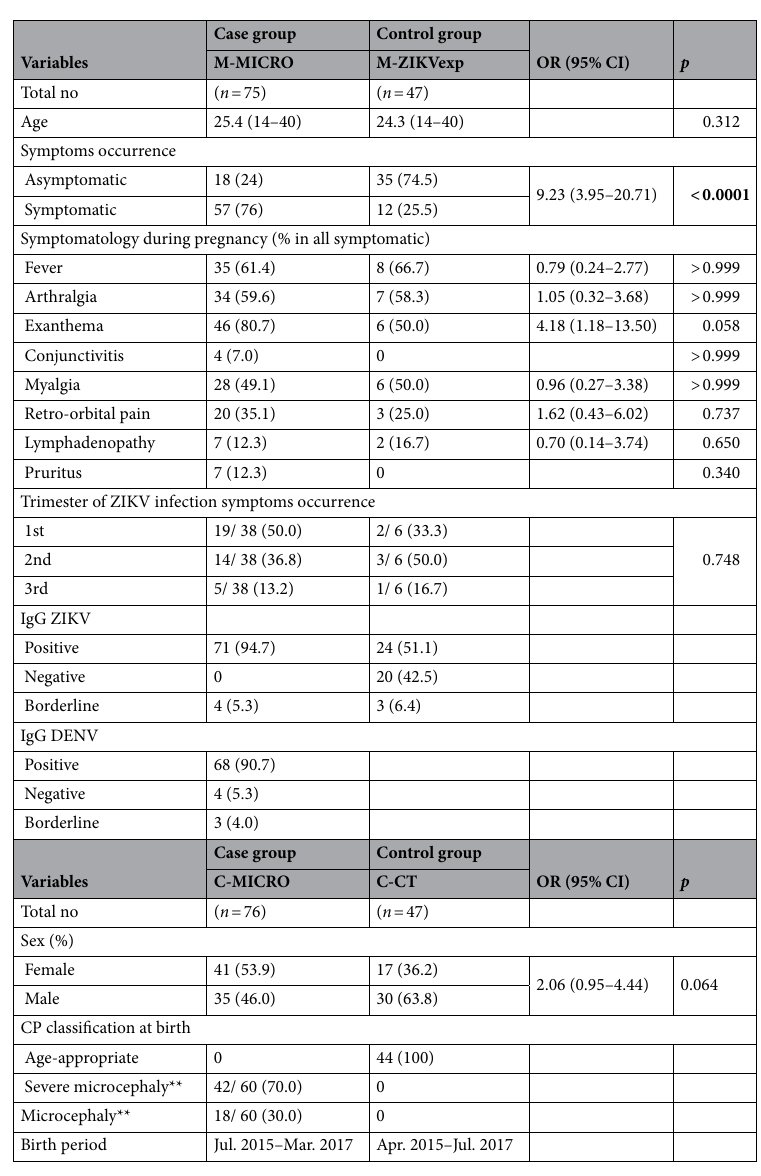
Table 1. Clinical-epidemiological characteristics of the cohort from Northeast Brazil. M-MICRO, women who gave birth to infants with congenital Zika syndrome; M-ZIKVexp, mothers who living in ZIKV’s endemic areas who gave birth to healthy infants; C-MICRO, children with congenital Zika syndrome; C-CT, healthy children who were born of the mothers who living in ZIKV’s endemic areas; Symptomatic: report of two or more of the listed symptoms of ZIKV infection. Quantitative variables were compared between groups using Student’s t test or Mann–Whitney U test and are presented as mean minimum and maximum value; Categorical variables were compared between groups using Chi-squared test or Fisher’s exact test. Bold indicates statistically significant. **Individuals in this category may present other malformations in addition to